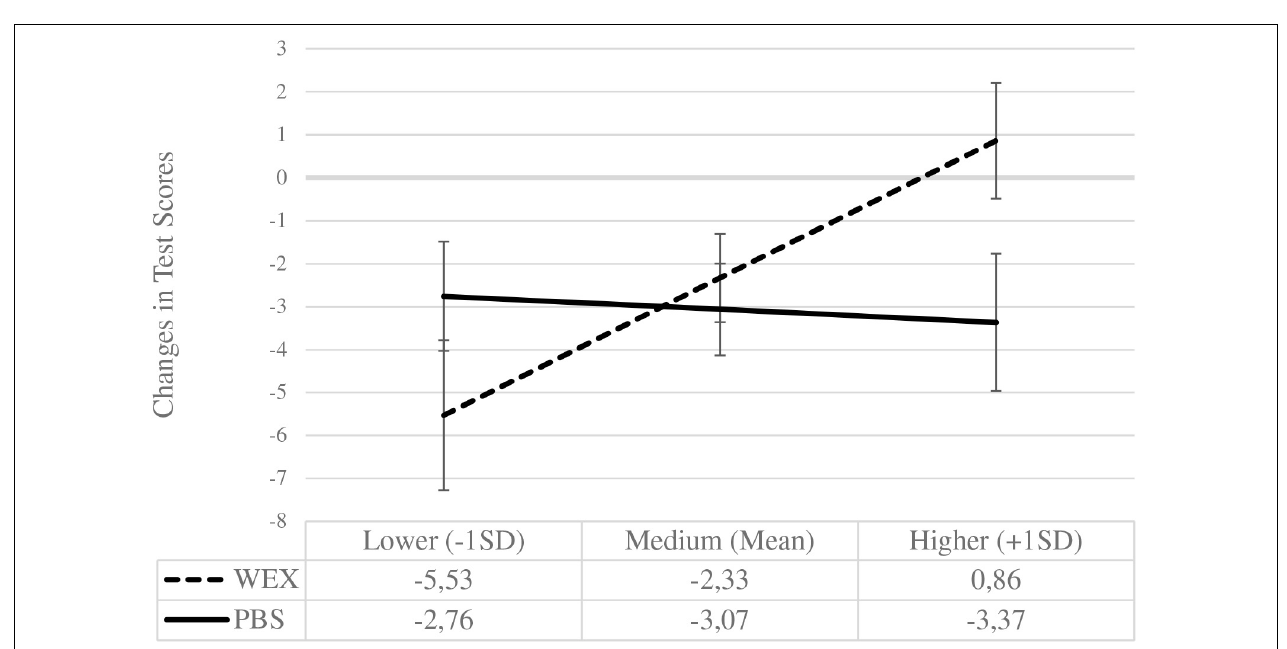
FIGURE 6 | Delayed post-test scores for both learning conditions at different levels of initial performance expectancies. WEX, worked-examples (0), n = 32; PBS, problem-solving (1), n = 29. Error bars represent the standard error of the mean [WEX: 1.91 (–1SD), 1.13 (Mean), 1.48 (+1SD); PBS: 1.40 (–1SD), 1.17 (Mean), 1.75 (+1SD)]. Performance expectancies (standardized) are depicted for lower, medium, and higher levels. Post-test scores could range from 0 to 42.